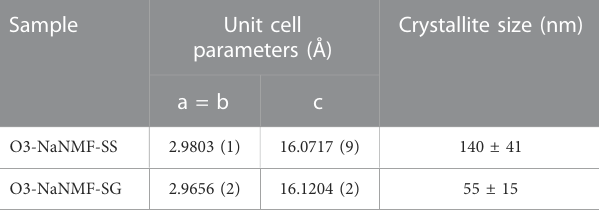
TABLE 1 Unit Cell Parameters and crystallite size of synthesis compounds obtained by Le Bail re fi nements.